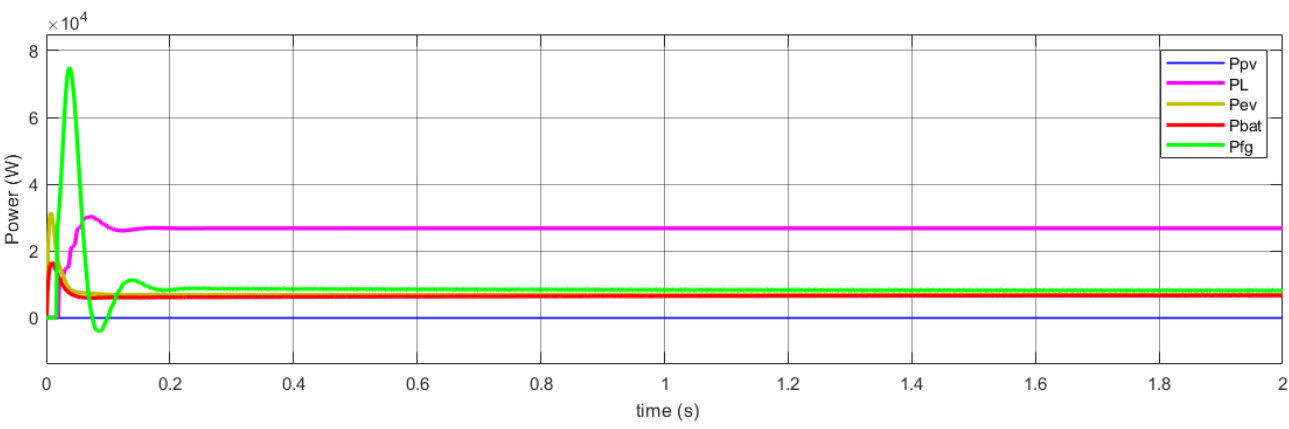
Figure 10. Power distribution in the system.